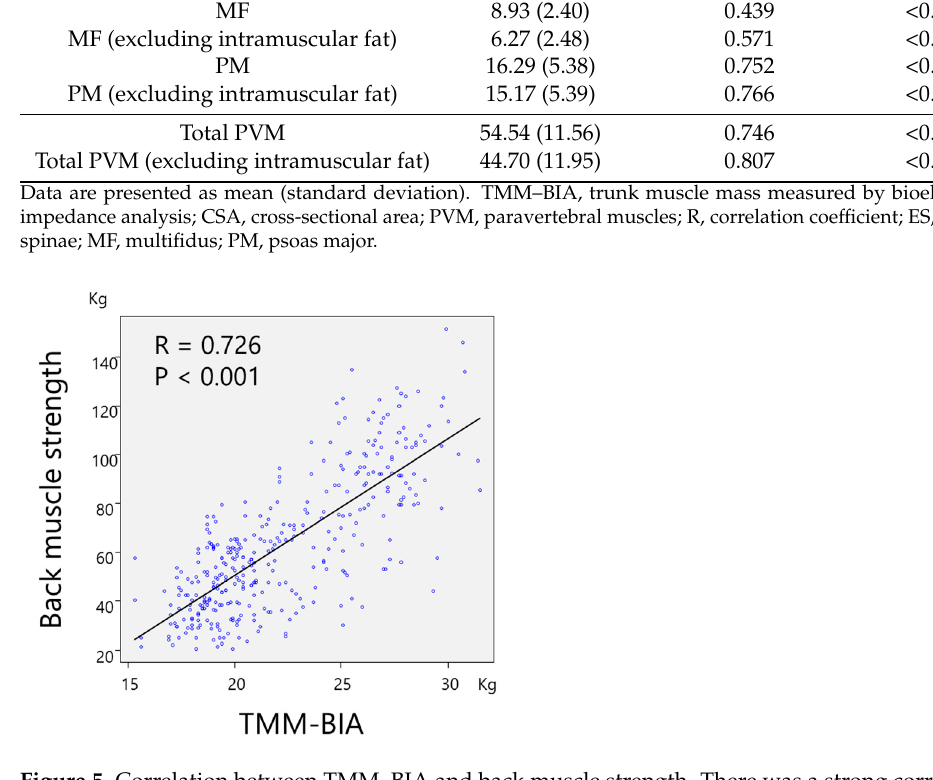
Figure 5. Correlation between TMM–BIA and back muscle strength. There was a strong correlation of r = 0.726, even though some of the participants exhibited minimum strength because of pain. TMM–BIA, trunk muscle mass measured by bioelectrical impedance analysis.